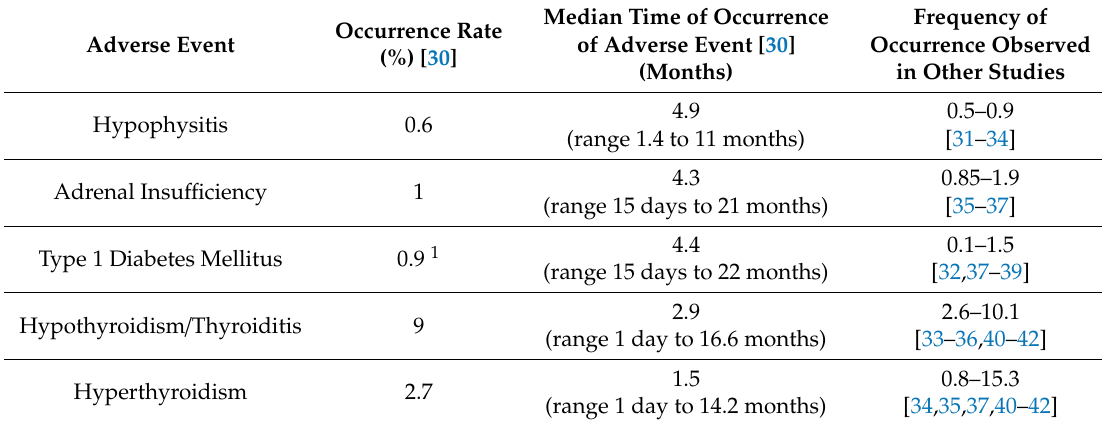
Table 1. Endocrine adverse e ff ects of nivolumab